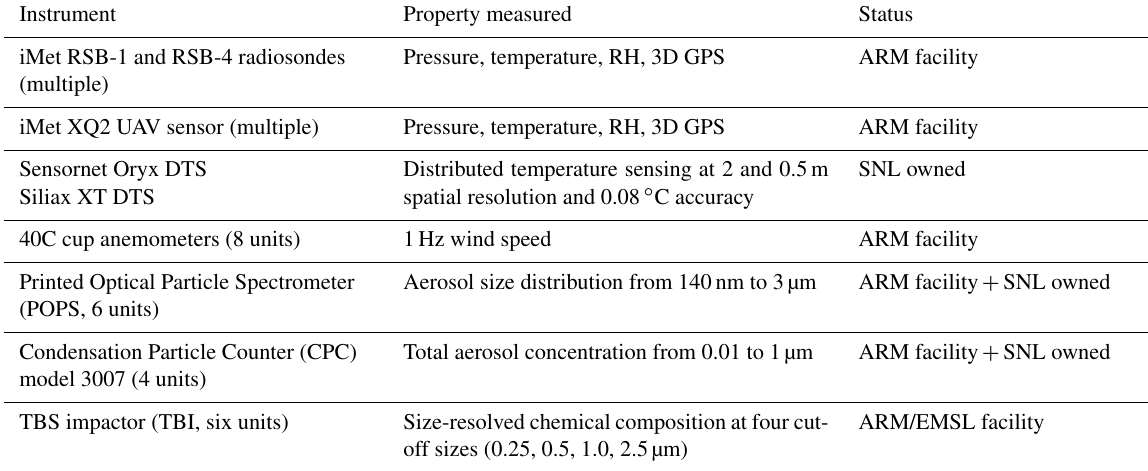
Table 1. The ARM TBS instrumentation deployed during the 2021 SGP missions.